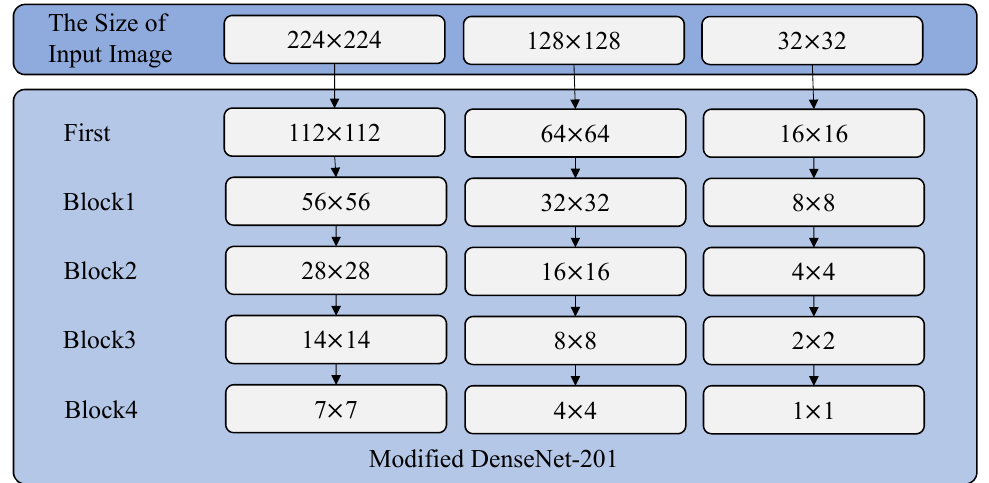
Figure 4. The size of the image according to each